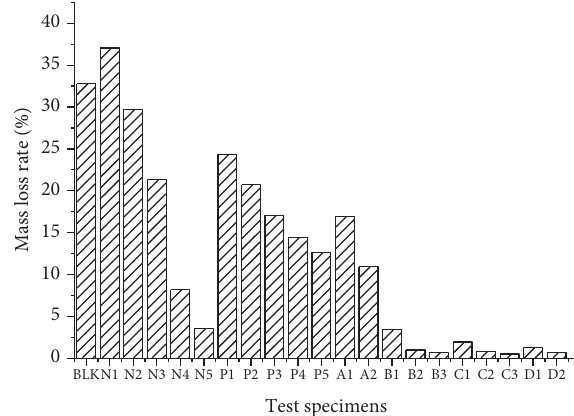
Figure 5: Mass loss rate of reinforcement.